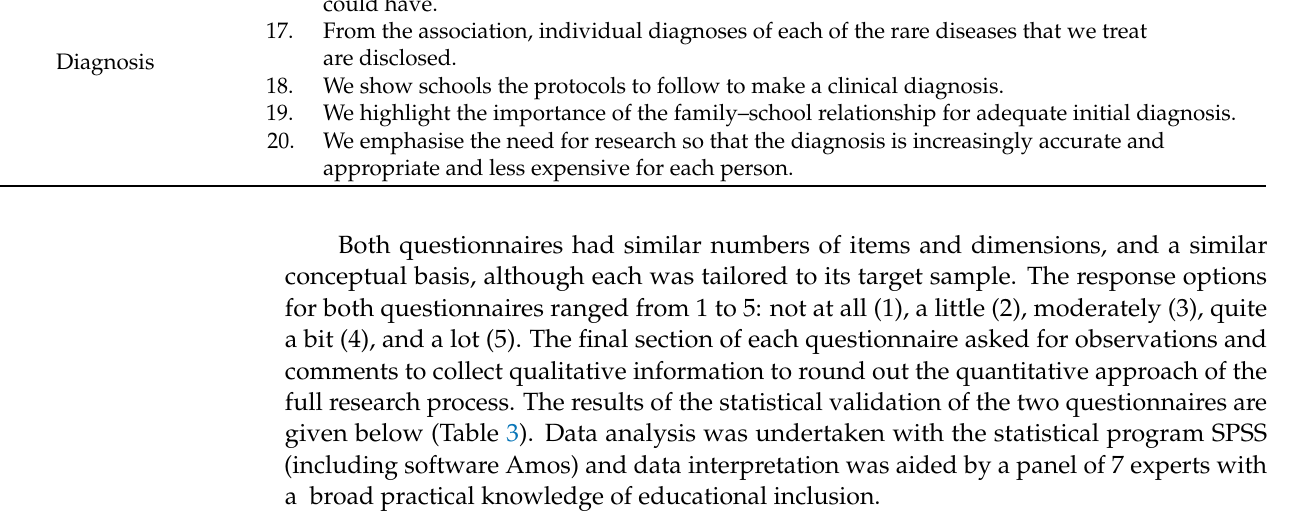
Table 3. Statistical validation of the two